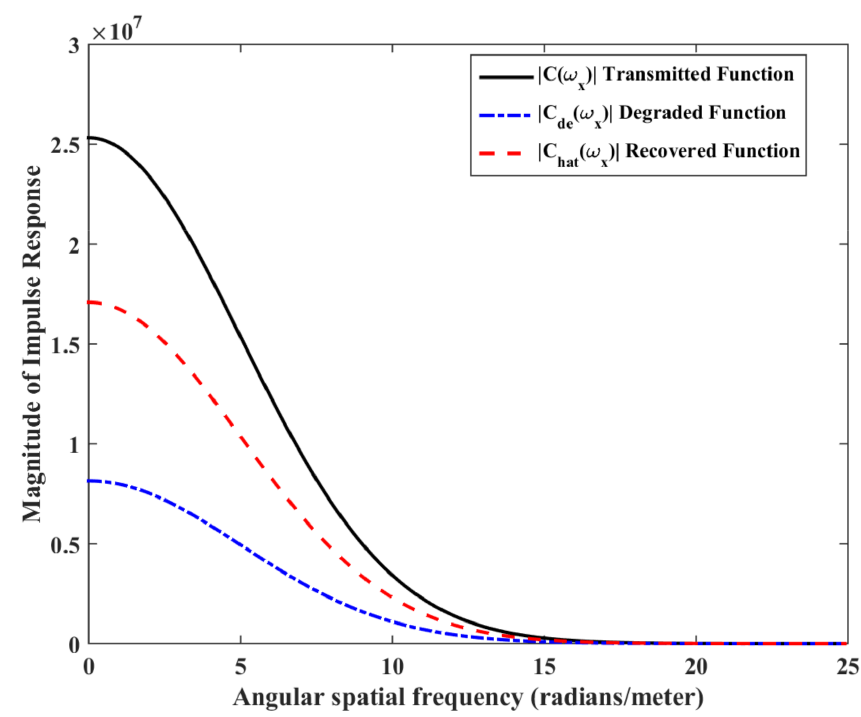
Figure 6. Impulse response magnitude versus spatial frequency of transmitted signal, degraded signal and recovered